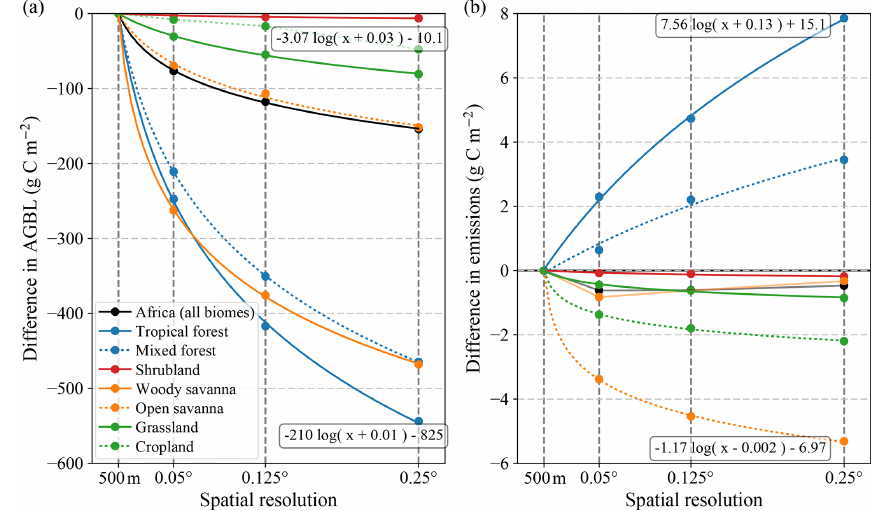
Figure 11. Average absolute simulation difference per biome compared to 500m for (a) AGBL and (b) fire emissions versus spatial resolu- tion. Data points are fitted with a natural logarithmic function where applicable. Inserted formulas show the corresponding fit functions for the two outermost lines. The plot axes are linear. For this plot, we assumed that 500m spatial resolution equals 0.005 ◦ on the x